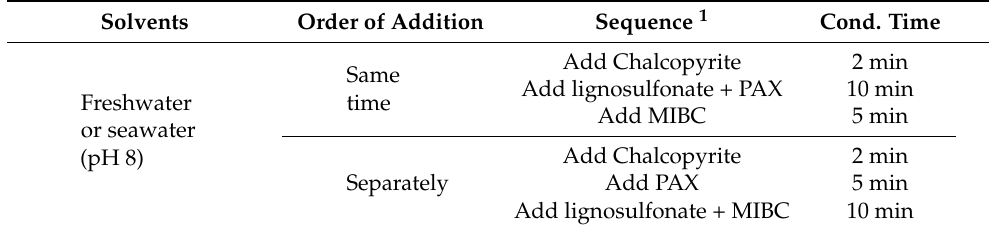
Table 3. Order of addition of the reagents on the recovery of chalcopyrite using Ca-LS (10 ppm) and Na-LS (10 ppm), PAX (25 ppm), and MIBC (15 ppm). Solvents Order of Addition Sequence 1 Cond.